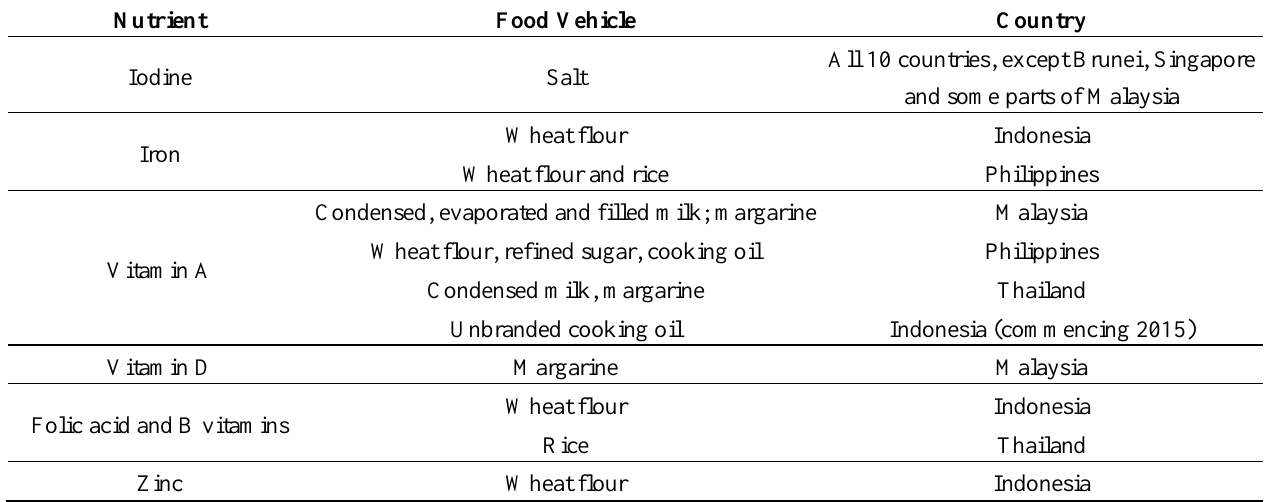
Table 1. Mandatory nutrient fortification in ASEAN